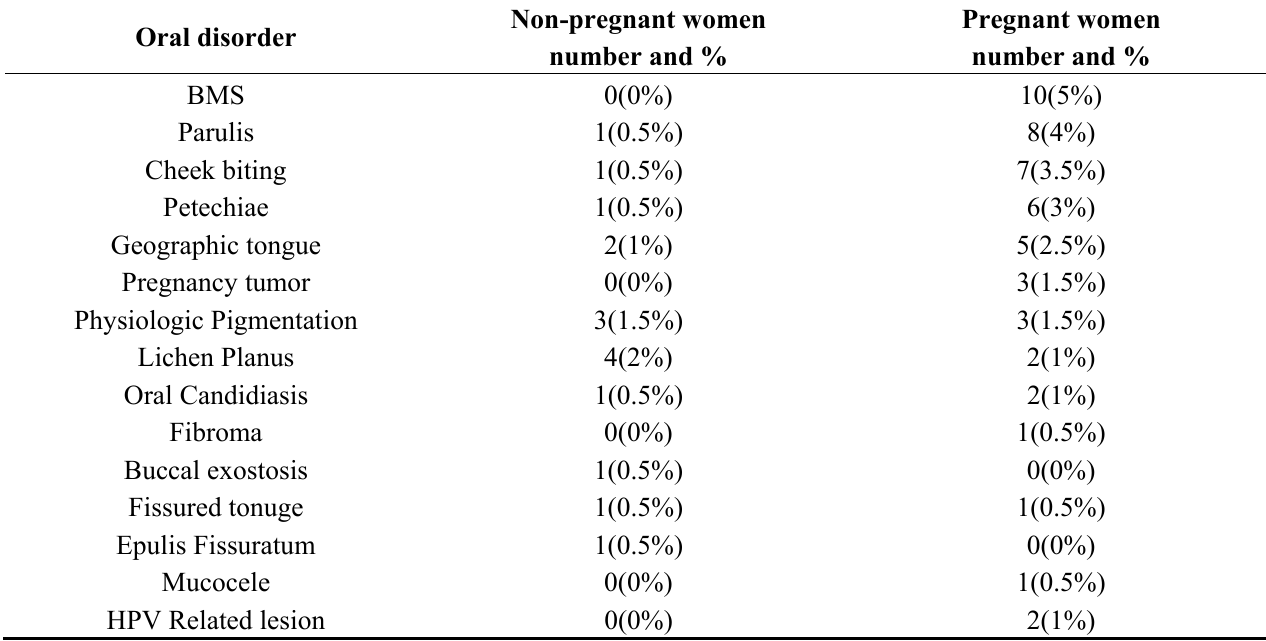
Table 1. Oral disorders in non-pregnant and pregnant women in this